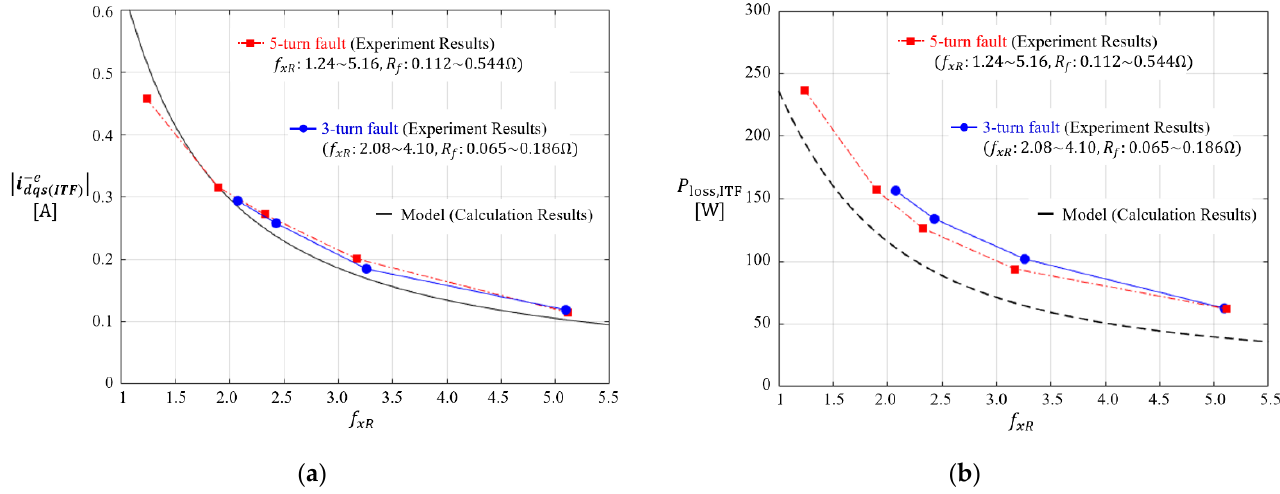
Figure 9. Calculated and experimental results of ( a ) the negative sequence current and ( b ) the copper loss generated in the ITF circuit vs. f xR .